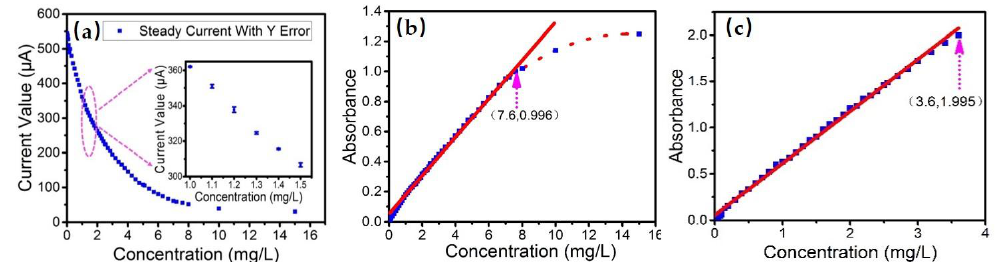
Figure 5. The results of test data statistics and analysis. ( a ) The exponential relation of I-c between the output current and the corresponding sample concentrations. ( b ) The relationship between the obtained absorbance and concentration. ( c ) A linear relationship between absorbance and concentration of reference.